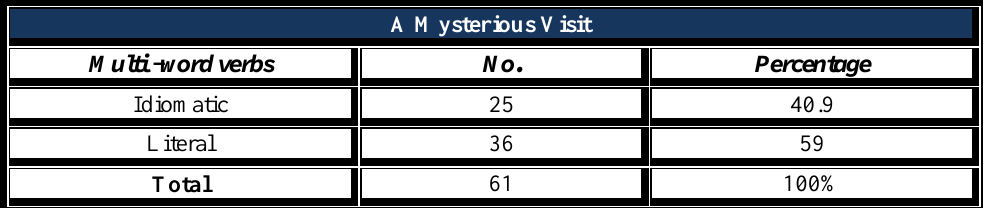
Table (4) deals with the divisions of literal and idiomatic PVs used in MV. The table is divided according to the story page numbers. Table 5 – The percentage of idiomatic and literal PVs in MV A Mysterious Visit